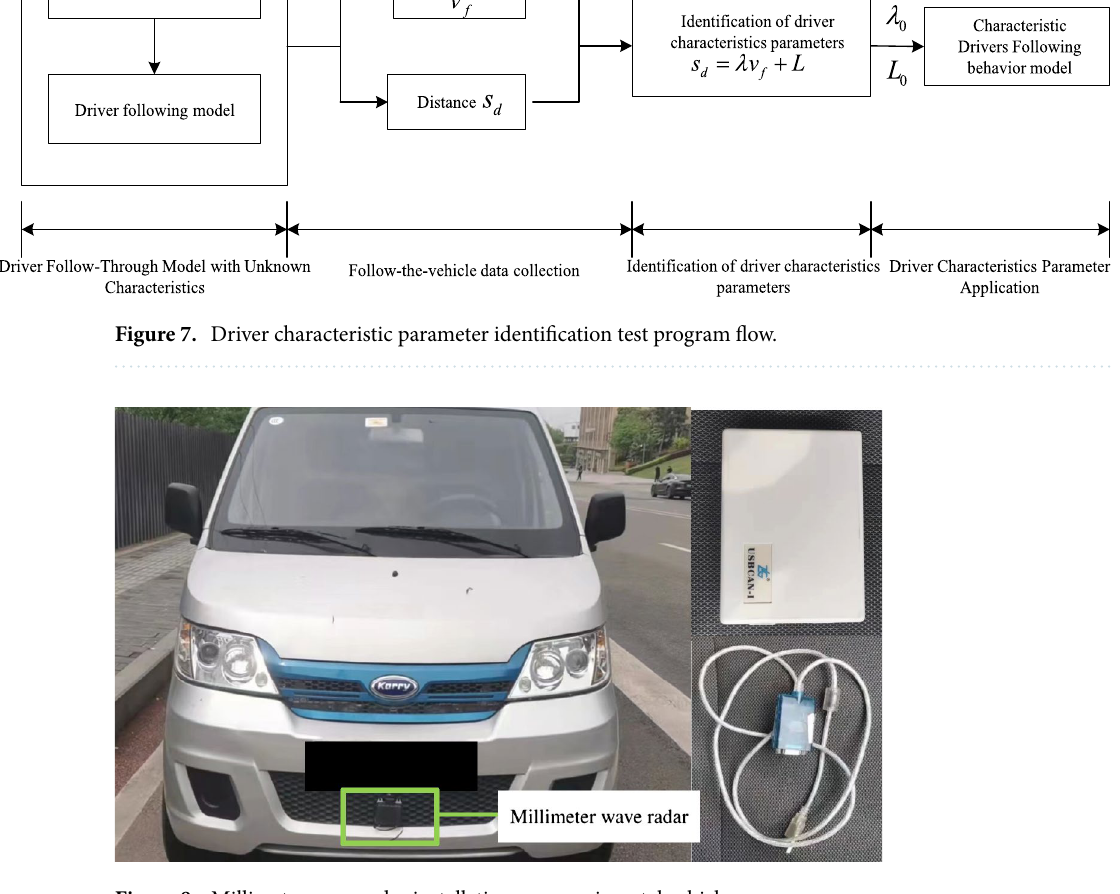
Figure 8. Millimeter wave radar installation on experimental